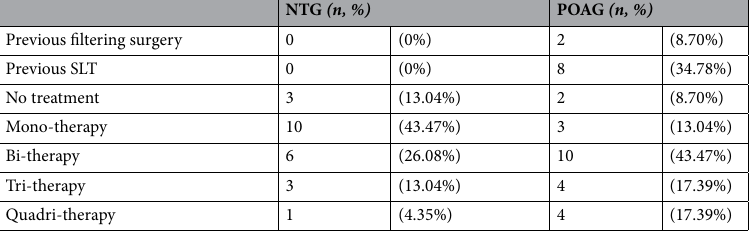
Table 2. Comparison of treatment history between normal tension glaucoma (NTG) and primary open- angle glaucoma (POAG) groups. Glaucoma hypotensive medications included prostaglandins, beta blockers, carbonic anhydrase inhibitors and/or alpha 2 adrenergic agonists. SLT selective laser trabeculoplasty.